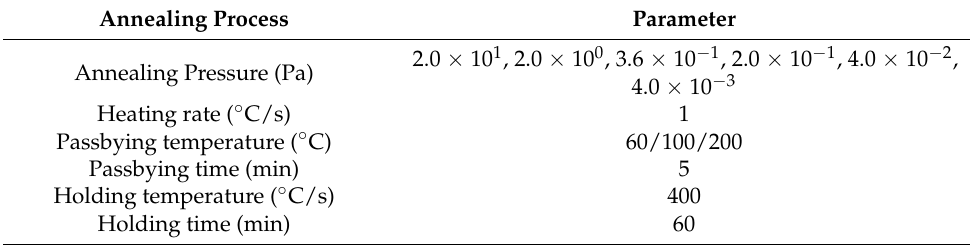
Table 2. Annealing process parameter of F-doped SnO 2